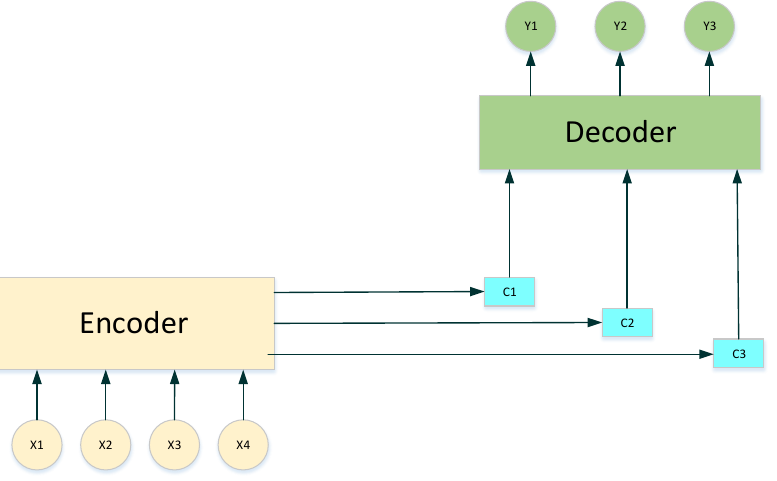
Figure 1. Sequence to sequence (seq2seq)